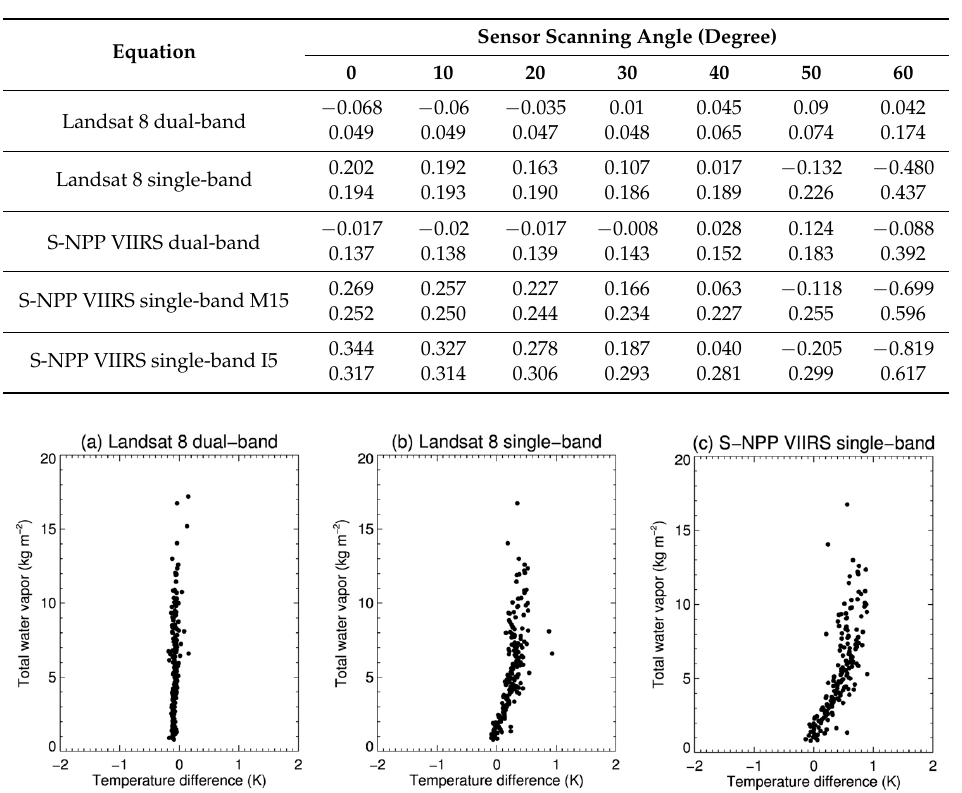
Figure 1. Relationship of the temperature difference between the retrieved and true ice surface temperature and total column water vapor for the ( a ) Landsat 8 dual-band algorithm using Equation (1), ( b ) Landsat 8 single-band using Equation (2), and ( c ) S-NPP VIIRS single-band for I5 band using Equation